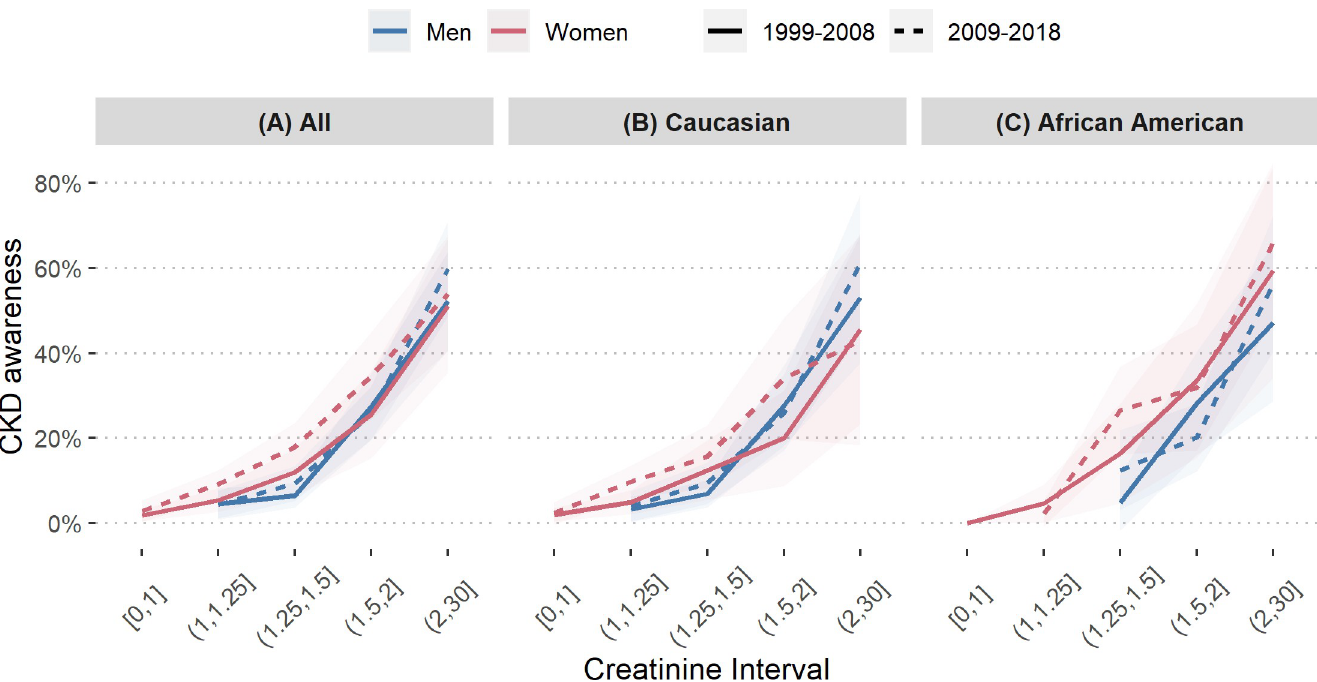
Fig 4. Chronic kidney disease awareness of men versus women by creatinine. Chronic kidney disease awareness of men versus women in NHANES 1999–2008 and 2009–2018, by creatinine interval, of all study participants (A), Caucasians (B) and African Americans (C).